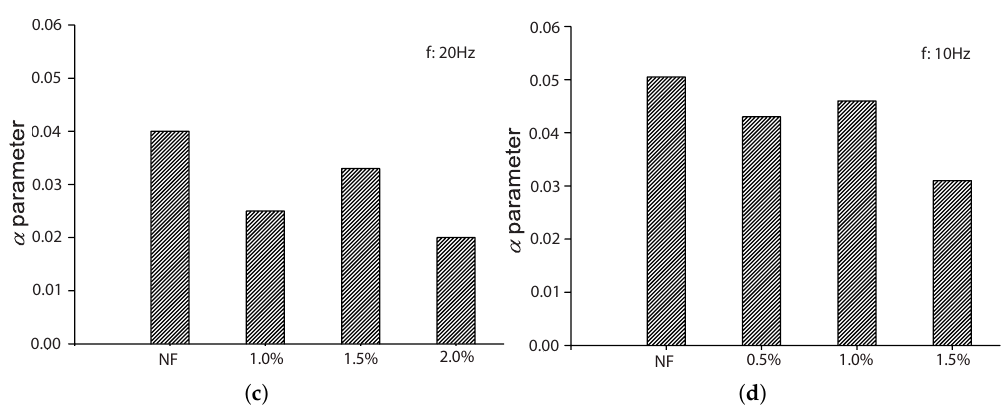
Figure 13. Influence of fiber volume fraction on parameter α : ( a ) Singh et al. [42]; ( b ) Mohammadi and Kaushik [17], 50-mm fibers; ( c ) Mohammadi and Kaushik [17], 25-mm fibers; ( d ) Goel and Singh [44].